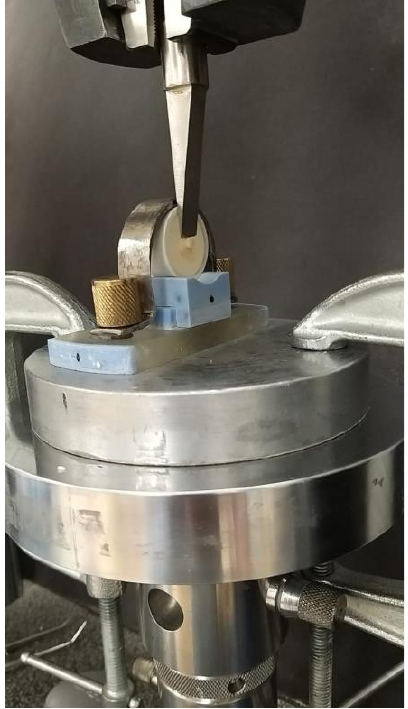
Figure 2. Micro-shear bond strength evaluation with INSTRON.